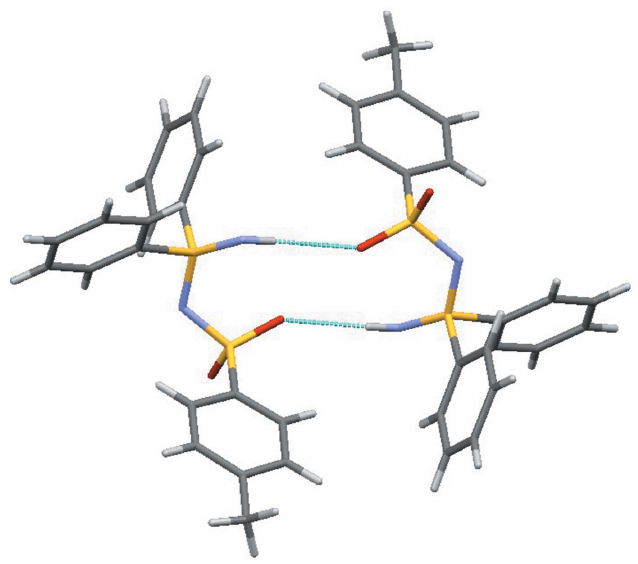
Figure 2 A view of the title compound showing a pair of N—H (cid:4)(cid:4)(cid:4) O hydrogen bonds (blue dashed lines) forming an R 2